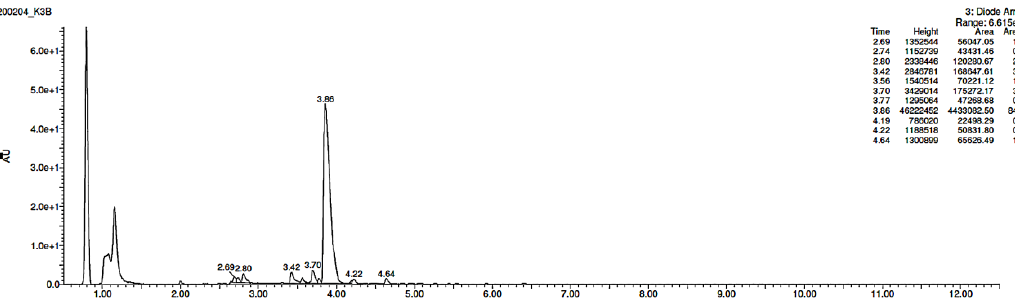
Figure 14. UPLC chromatogram of ketotifen (KET) and its degradation products in a solution of pH 7.0.